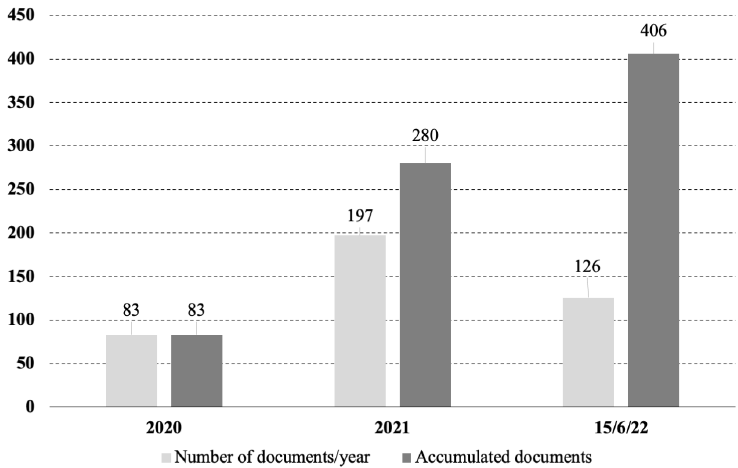
Figure 2. Number of documents per year and accumulated documents published in the time